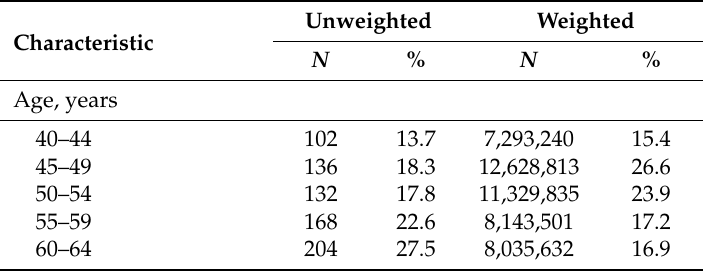
Table 1. Sample characteristics ( n =